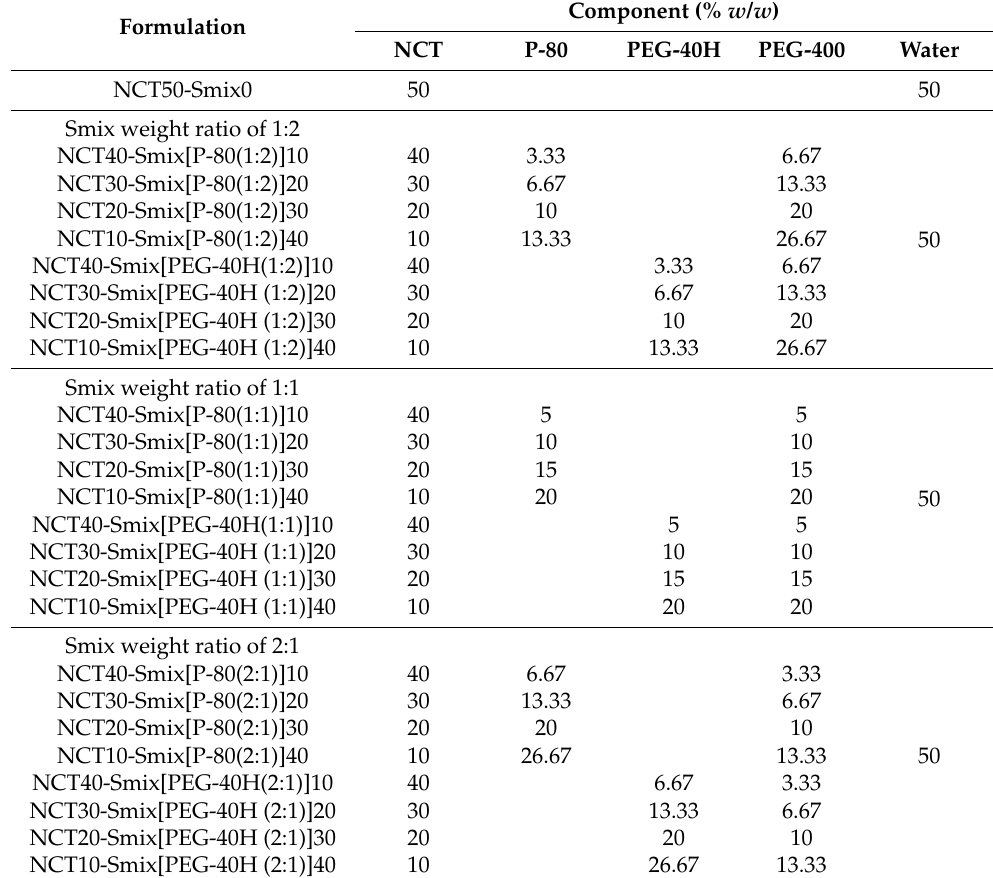
Table 5. Type and concentration (% w / w ) of the components used in each preparation of NCT-ME.